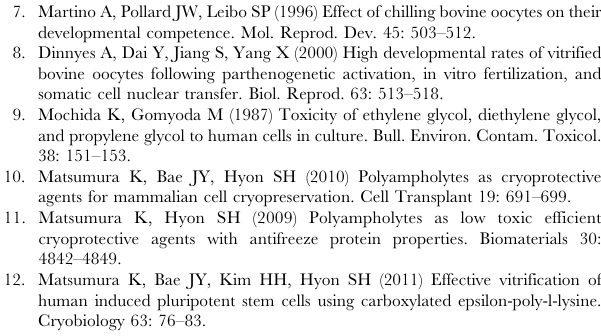
Figure S1 Morphology of COCs exposed to vitrification media supplemented with EG alone and EG plus COOH- PLL. (TIF)